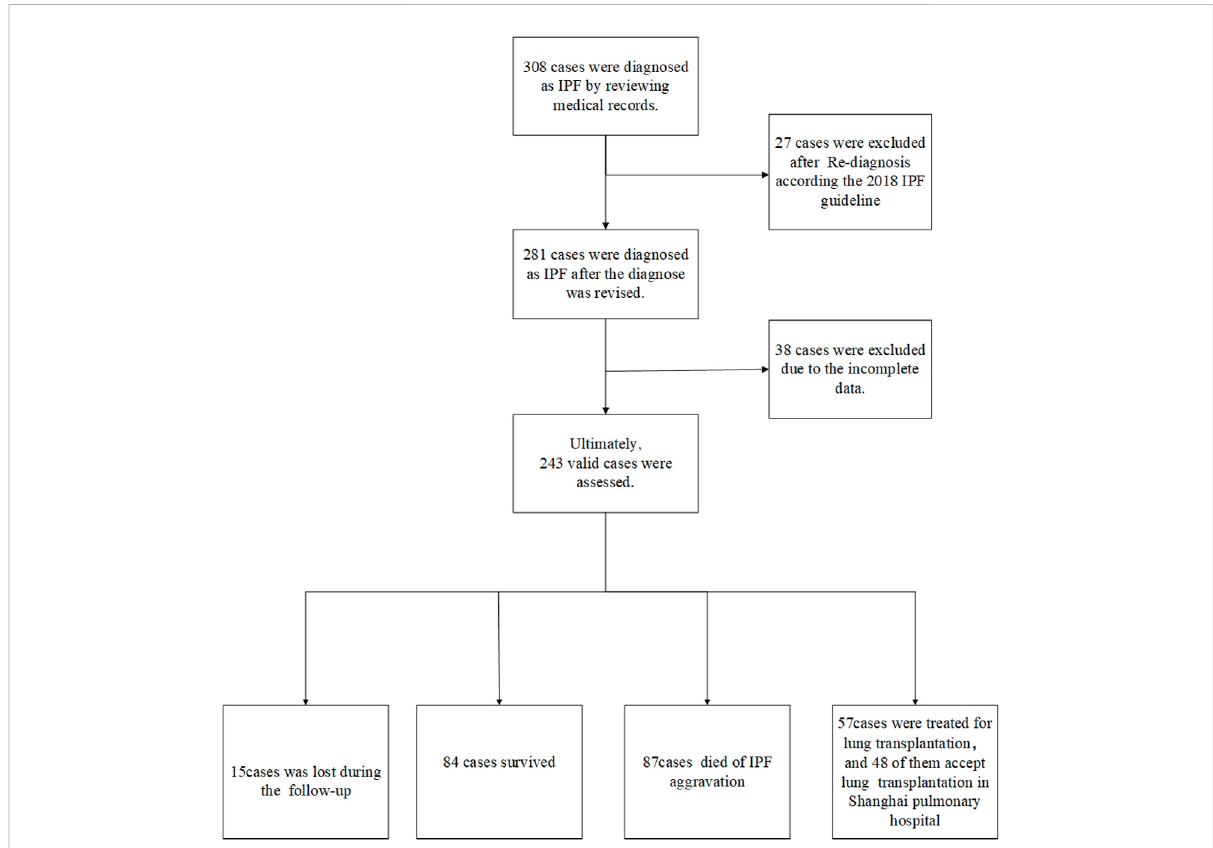
FIGURE 1 CasescreeningprocessAtotalof308caseswerediagnosedwithIPFbyreviewingthemedicalrecords.Moreover,27caseswereexcludedafter re-diagnosisaccordingtothe2018IPFguideline.Besides,38caseshadincompleteCTandlungfunctiondata.Finally,243caseswereincludedinthe fi nalretrospectiveanalysis,including57cases undergoinglungtransplantation. Therewere84 surviving cases,and 15 caseswerelostduring follow- up. Besides, 87 deaths happened due to acute exacerbation of IPF, 57 patients underwent lung transplantation, and 48 of them accepted transplantation in Shanghai Pulmonary